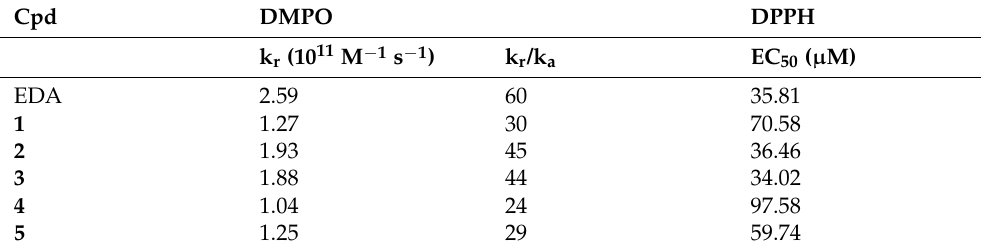
Table 2. Antioxidant properties of the test compounds.